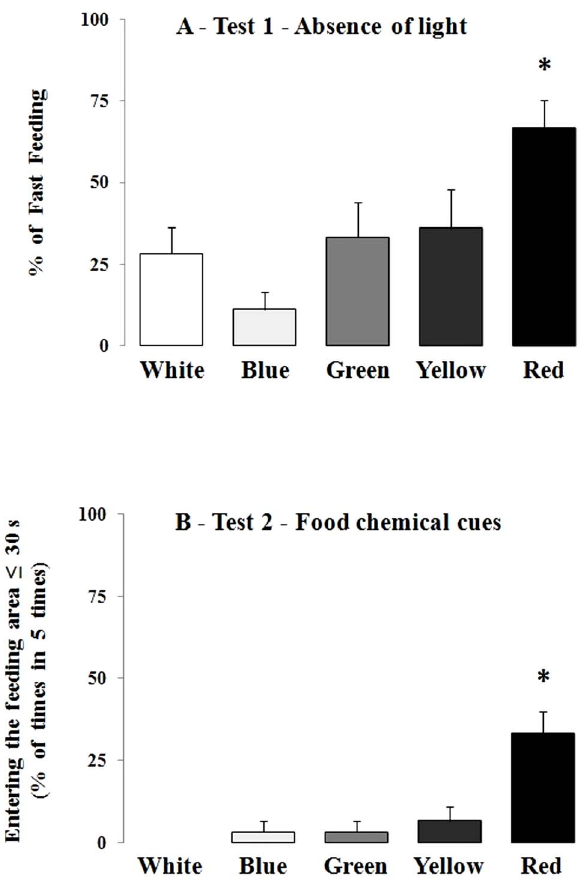
Figure 2. Effect of holding color on feeding behavior stimulated by non-visual cues. A – Percentage of first snatch emitted to pellets in the absence of light. N=6 fish each color. B – Feeding behavior (entering the chemical cue area) stimulated by food chemical cues (no pellets were present). Means ( 6 SEM) of 6 fish for each color (white color N=5). Asterisk indicates higher mean compared to the other color treatments (not different among themselves): ANOVA, A) P=0.005 and B) P=0.000052.